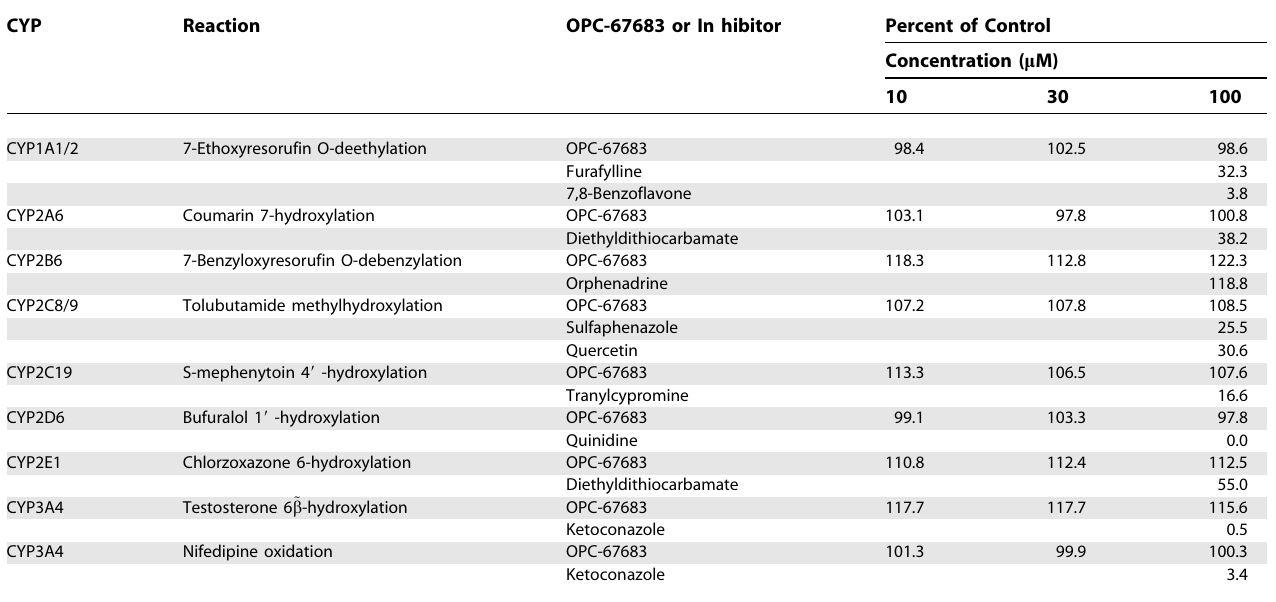
Table 8. Effect of OPC-67683 on CYP1A1/2, CYP2A6, CYP2B6, CYP2C8/9, CYP2C19, CYP2D6, CYP2E1, and CYP3A4 Mediated Reactions in Human Liver